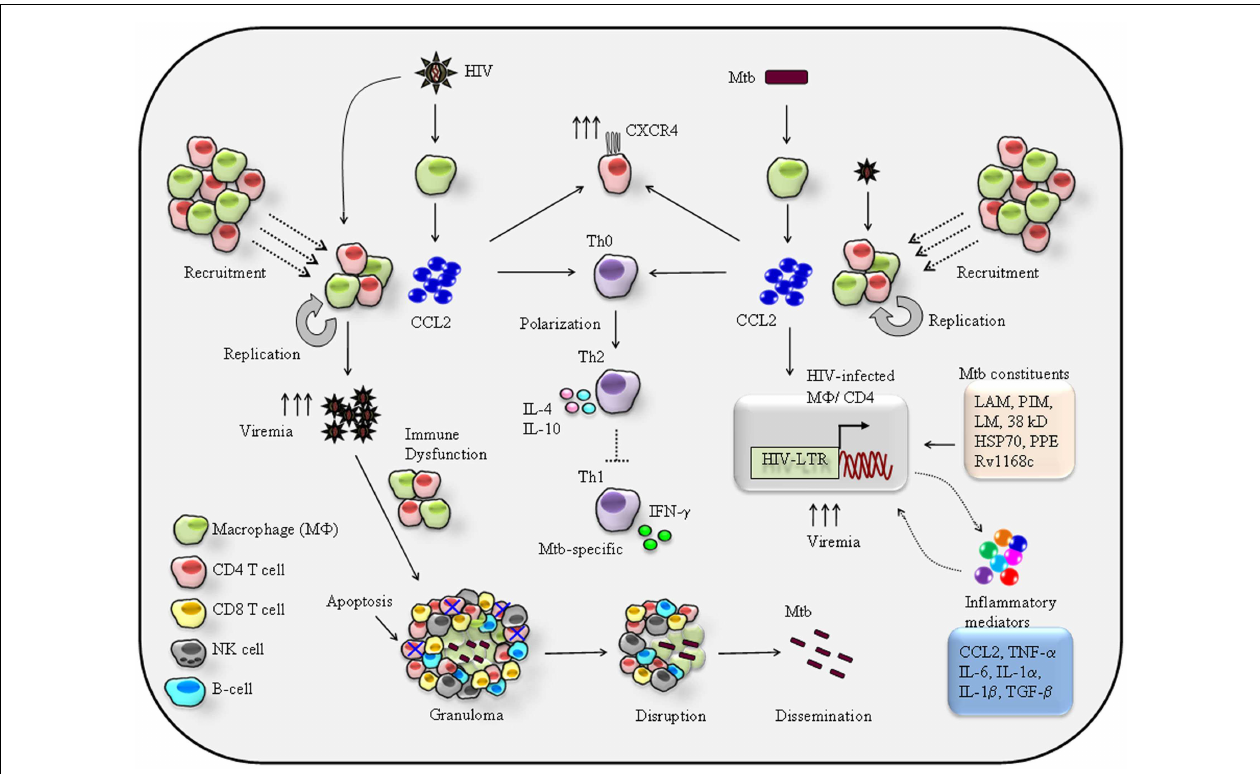
FIGURE 1 | Proposed mechanisms of reciprocal effects of CCL2-mediated immuno-pathogenesis of HIV/Mtb co-infection . HIV-1 infection of alveolar macrophage releases CCL2 that recruits monocytes/macrophages and CD4 + T cells at the site of infection hence increase the pool of HIV-1 permissive cells for new round of replication-the feed-back loop model (4, 17) eventually persistence of a high viremia in the BAL. CCL2 can acts on resting CD4 + T cells to induce expression of HIV-1 co-receptor CXCR4, thereby rendering them susceptible to infection by X4 strains (38). CCL2 known to trigger differentiation ofTh0 towardTh2 phenotype (39) via CCL2–CCR2 axis.Therefore, in the lung a high